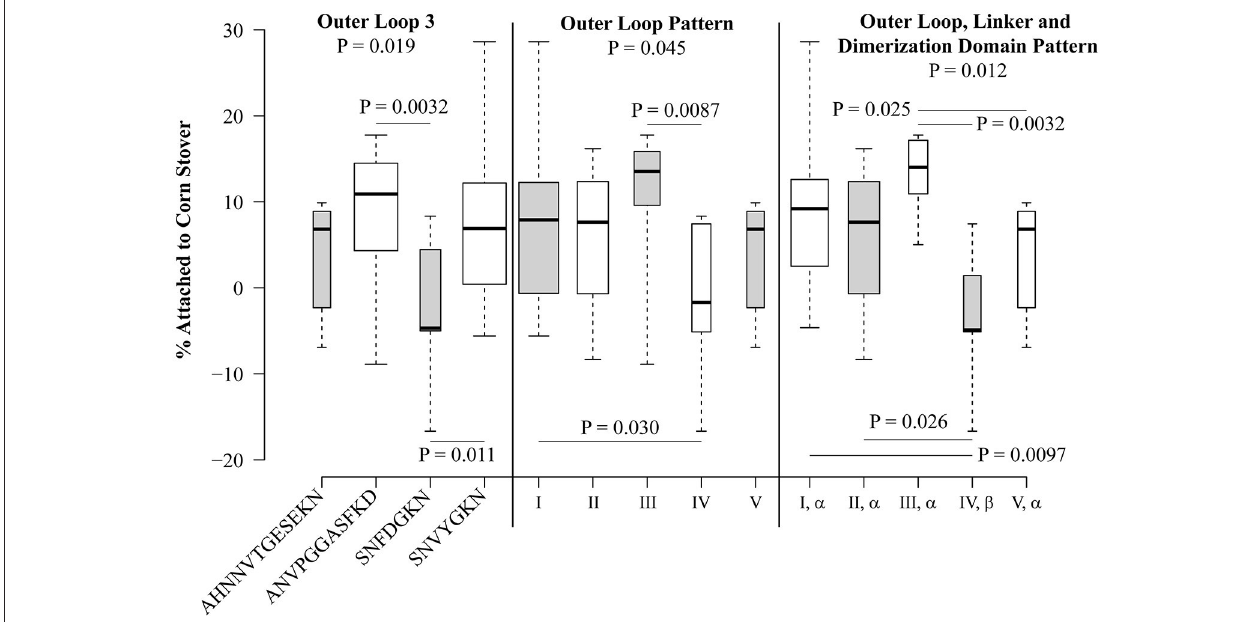
FIGURE 5 | Polymorphisms within OmpA are significantly associated with attachment of E. coli isolates to corn stover. Box plots were generated using BoxPlotR. The whiskers indicate the minimum and maximum values. The bottom of the box is the 1st quartile and the top of the box indicates the 3rd quartile. The dark line within the box is the median value. Box width is scaled according to the number of strains in each group. Shading of the boxes is for improved readability and does not convey meaning. Group-wide P -values were determined using one-way ANOVA, P -values between individual sequences and patterns were determined using the Student’s t